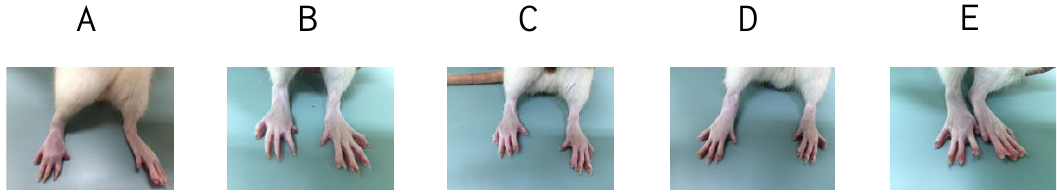
Figure 4. Edema status after oral treatment (on day 25) with diacetylcurcumin (DAC) at different doses. (A) Vehicle, (B) DAC 60 mg/kg, (C) DAC 120 mg/kg, (D) DAC 150 mg/kg and Phenylbutazone (80 mg/kg) (E).